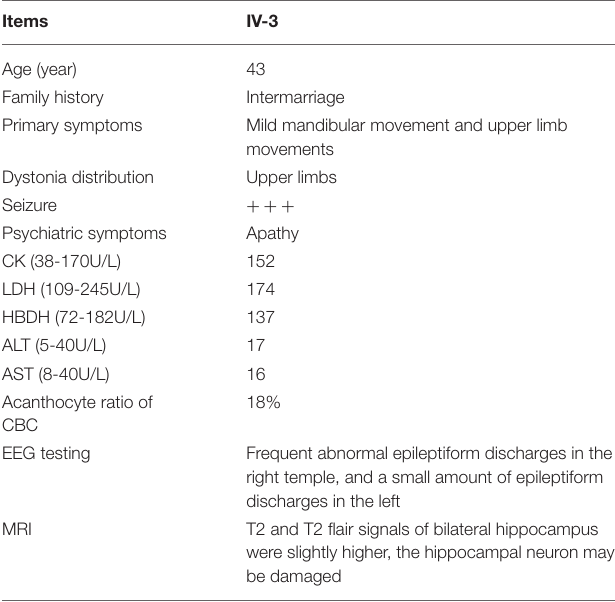
TABLE 1 | The clinical summary of the patient.